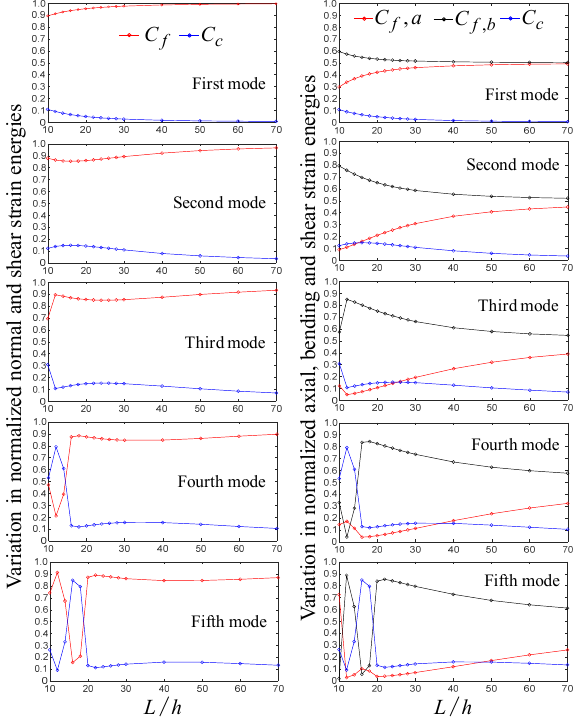
Figure 4. Variation in the strain energies on the natural frequencies of three ‐ layered beams with the C ‐ F end condition.